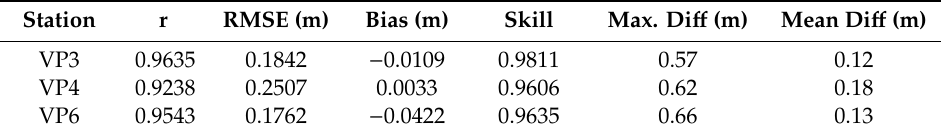
Figure 3. Water level time series at the calibration stations. Field data (dotted black line) and numerical data (continuous grey line). Water levels refer to MSL (2 m above HZ) and the time starts 20 February 2006 00:00 h UTC. ( a ) Station VP3; ( b ) Station VP4; and ( c ) Station VP6. Table 4. Error metrics for the water elevation.